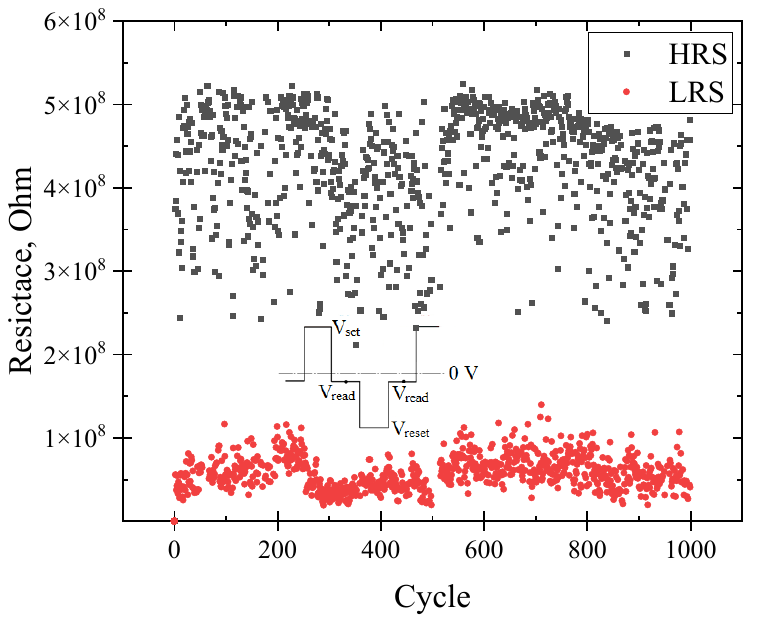
Figure 8. Endurance of memristors (resistance of memristors in HRS and LRS states under 1000 cycles).